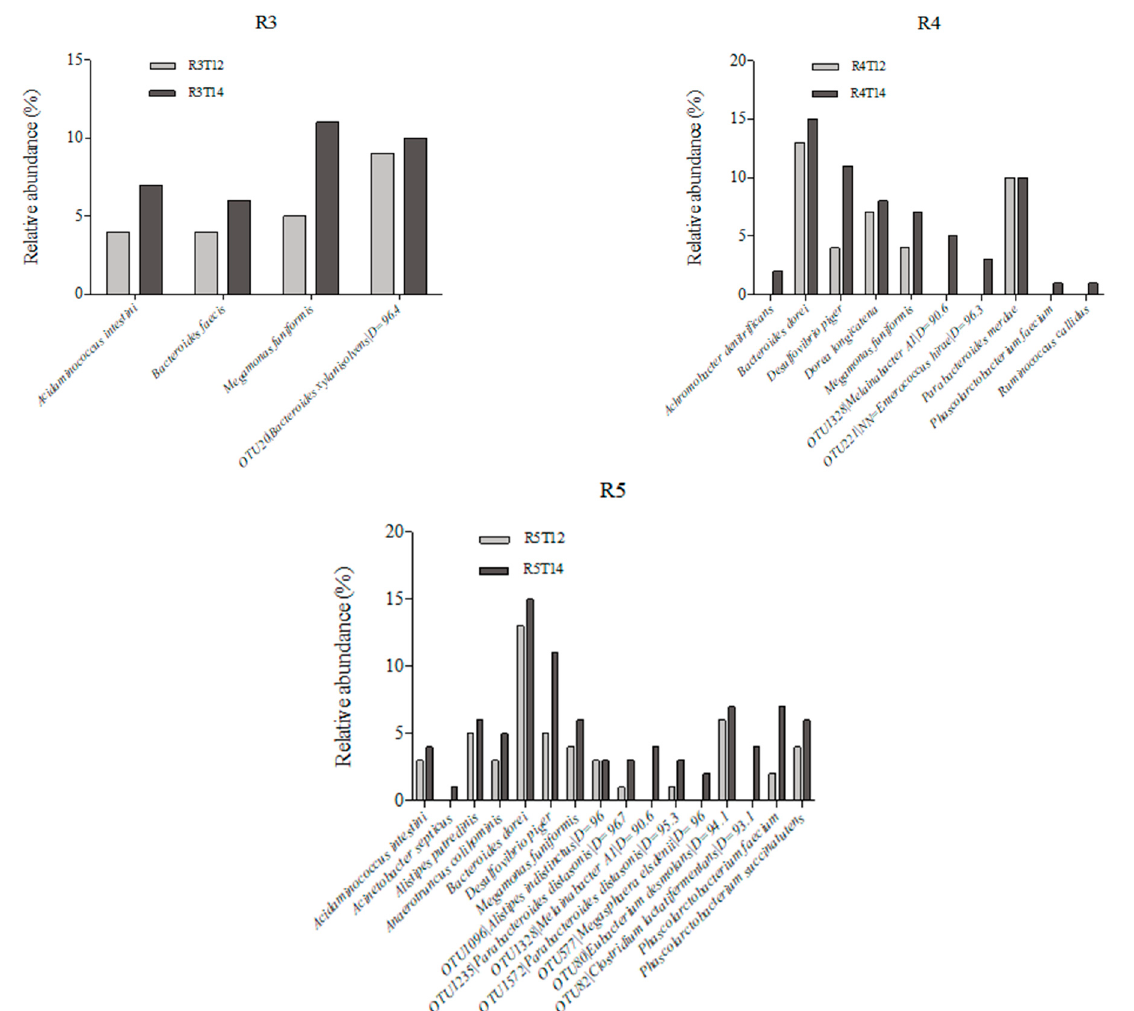
Figure 3. Representation of the bacteria species relative abundance on the different reactors: ( R3 ) ascending colon, ( R4 )